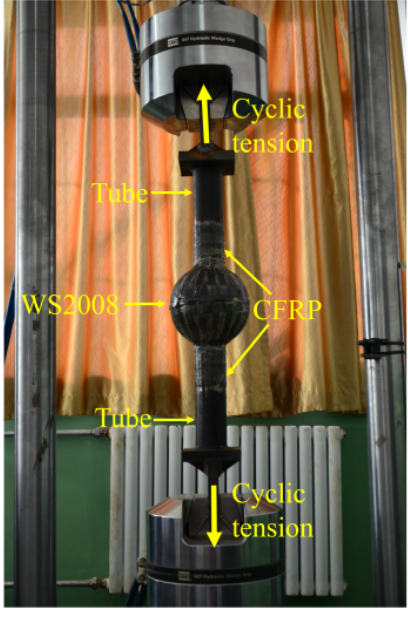
Figure 10. Test setup.